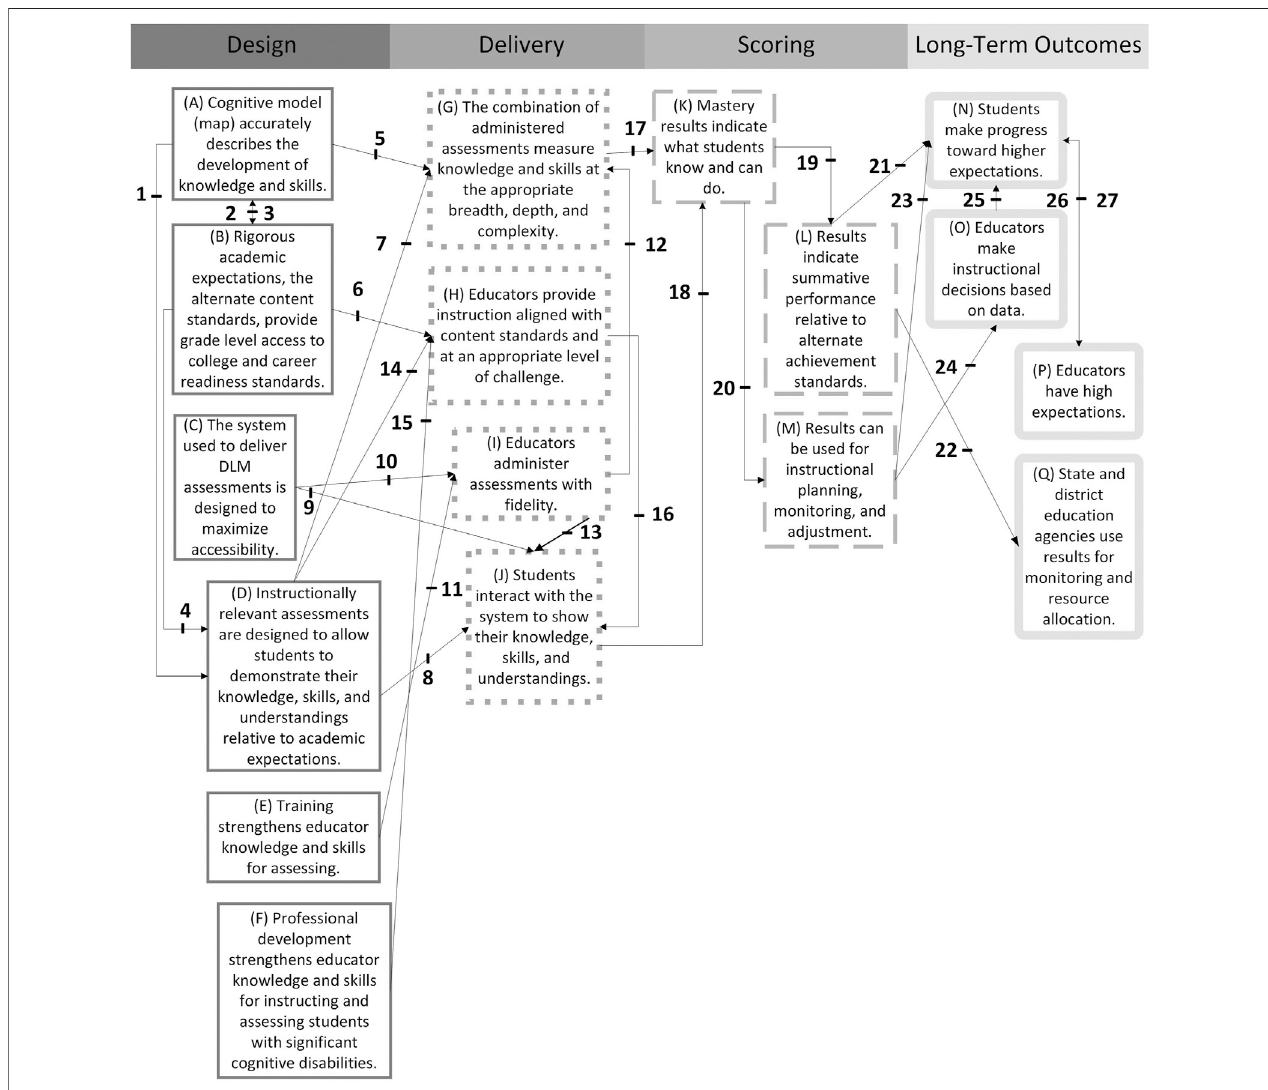
FIGURE 2 | Theory of action for the Dynamic Learning Maps Instructionally Embedded assessment